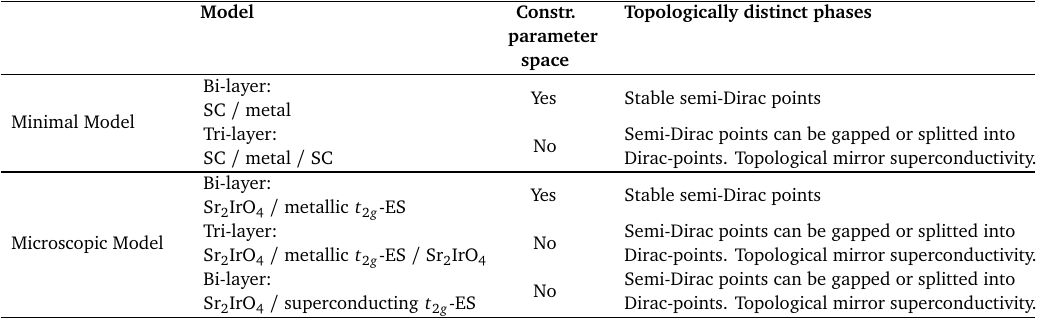
Table 1: Summary of the models discussed in the paper. For each model it is specified whether it is in the constrained parameter space, and we have also summarized the topologically dis- tinct phases it can support. The minimal models are discussed in Section 2 and the microscopic models in Sections